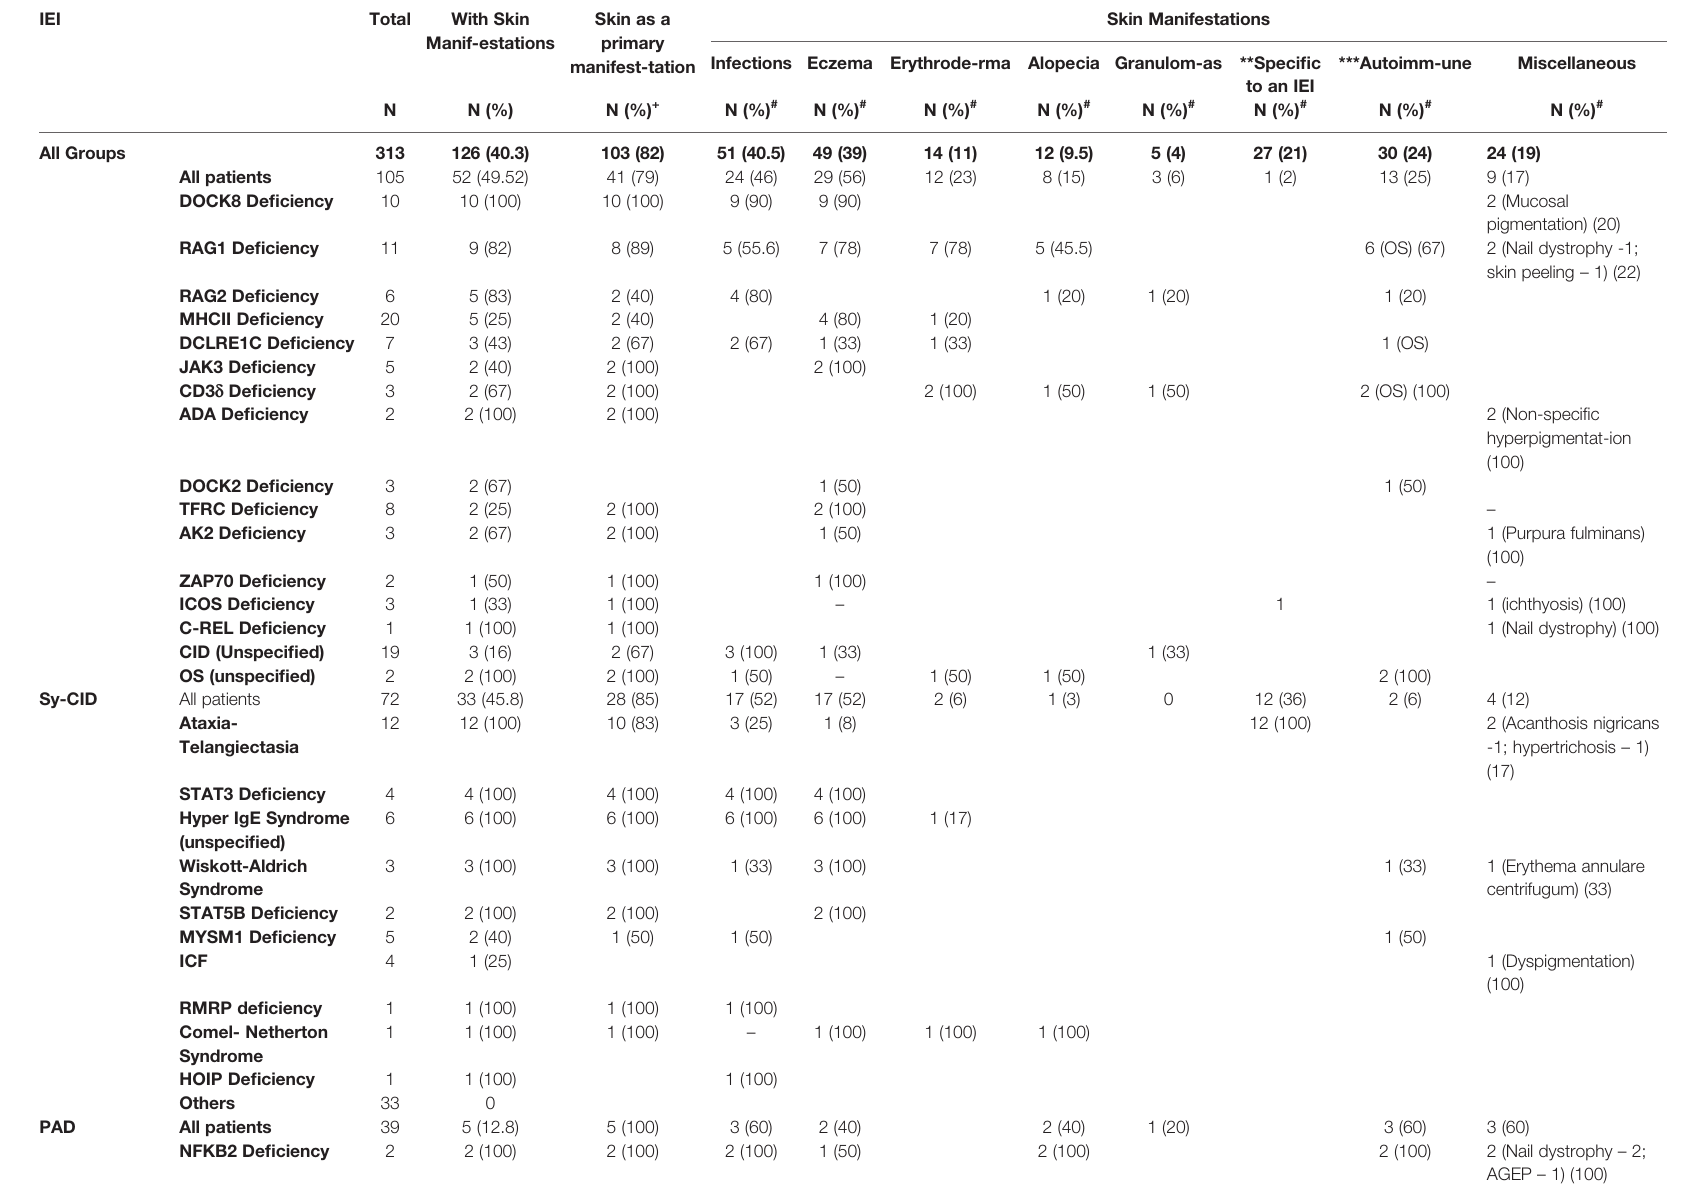
TABLE 3 | Characterization of skin manifestations according to speci fi c diagnosis among children with IEI registered in the KNPIDR.